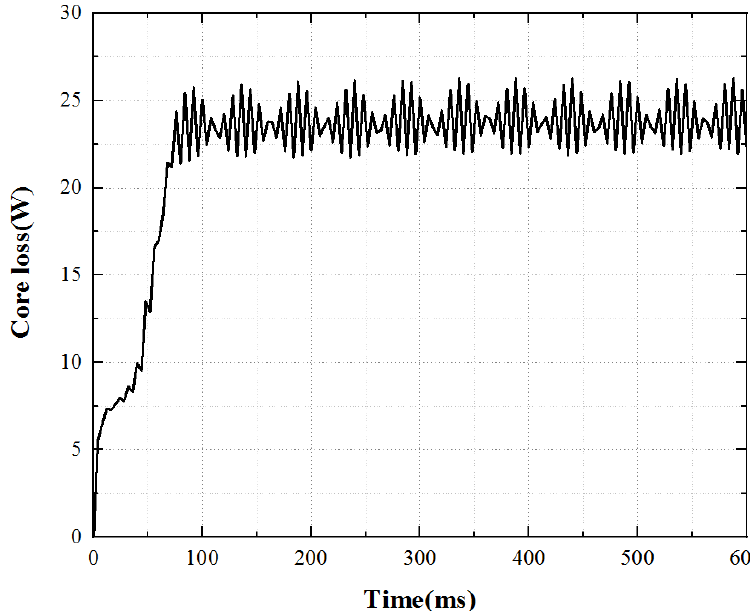
Figure 6. Core loss